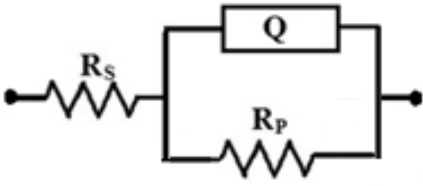
Figure 5. The circuit used in fitting the EIS experiments.